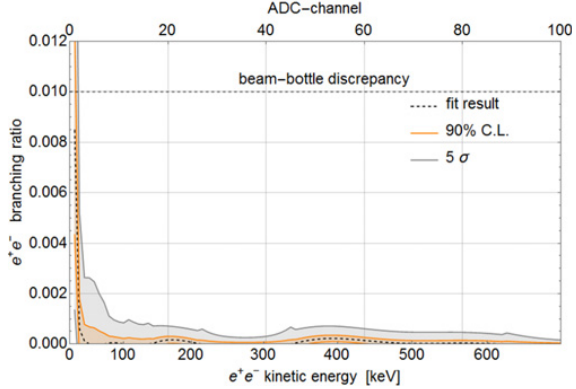
Figure 6. One out of 2 . 9 × 10 7 Monte-Carlo simulations used to determine the “Look-Elsewhere-Effect”. The strongest excitation extracted from the 2 . 9 × 10 7 simulated data sets is used as 5 σ statistical